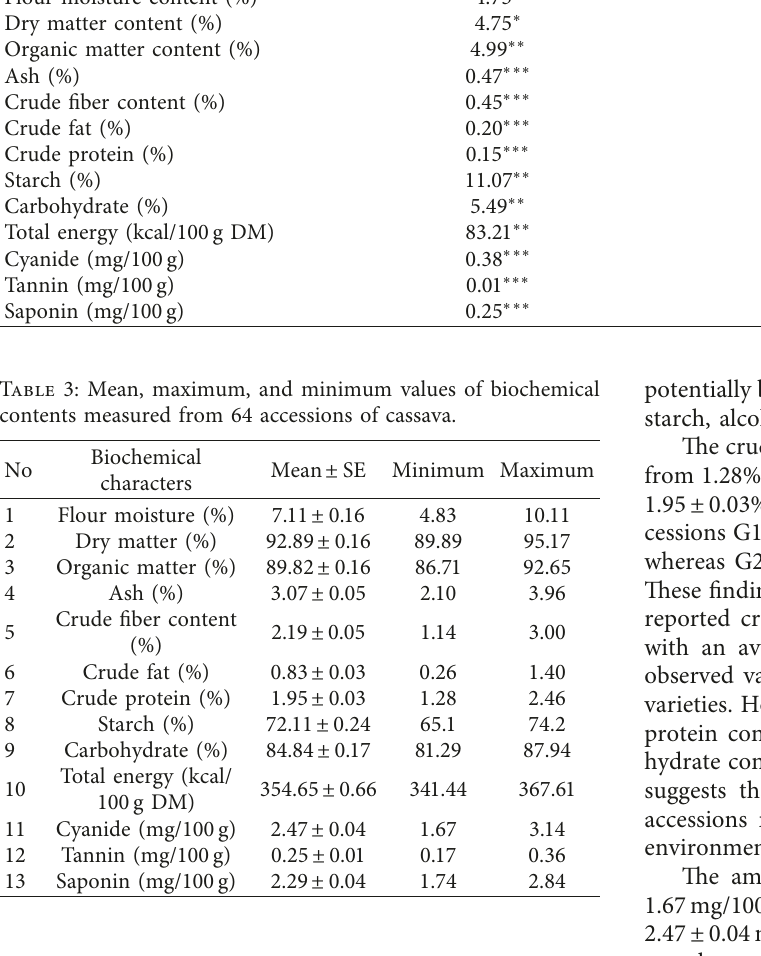
Table 2: Analysis of variance of 13 biochemical characters in 64 cassava accessions. Biochemical characters